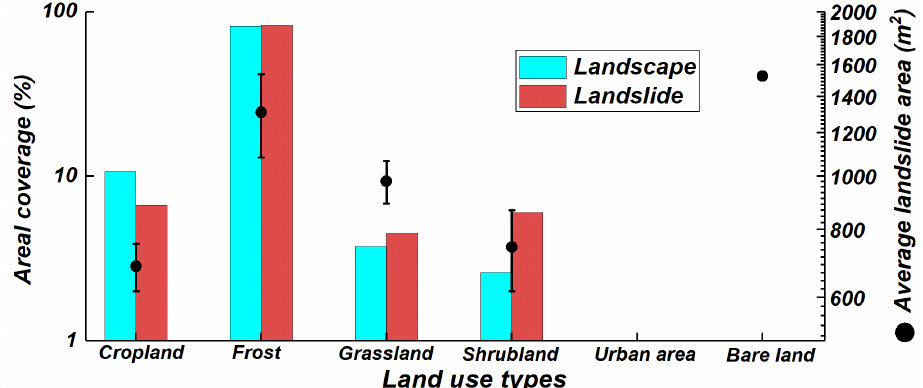
Figure 16. Areal coverage (%) of different land use types for both landslide and landscape overlaid by average landslide area calculated per each unit.